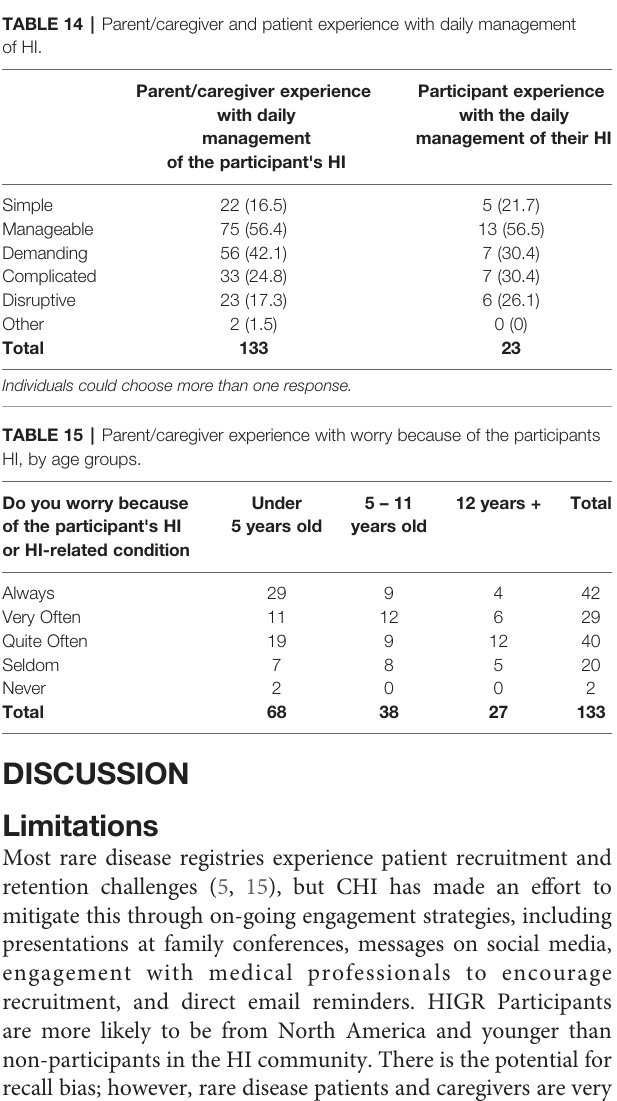
TABLE 13 | Reported developmental delays and neurological problems. TABLE 14 | Parent/caregiver and patient experience with daily management